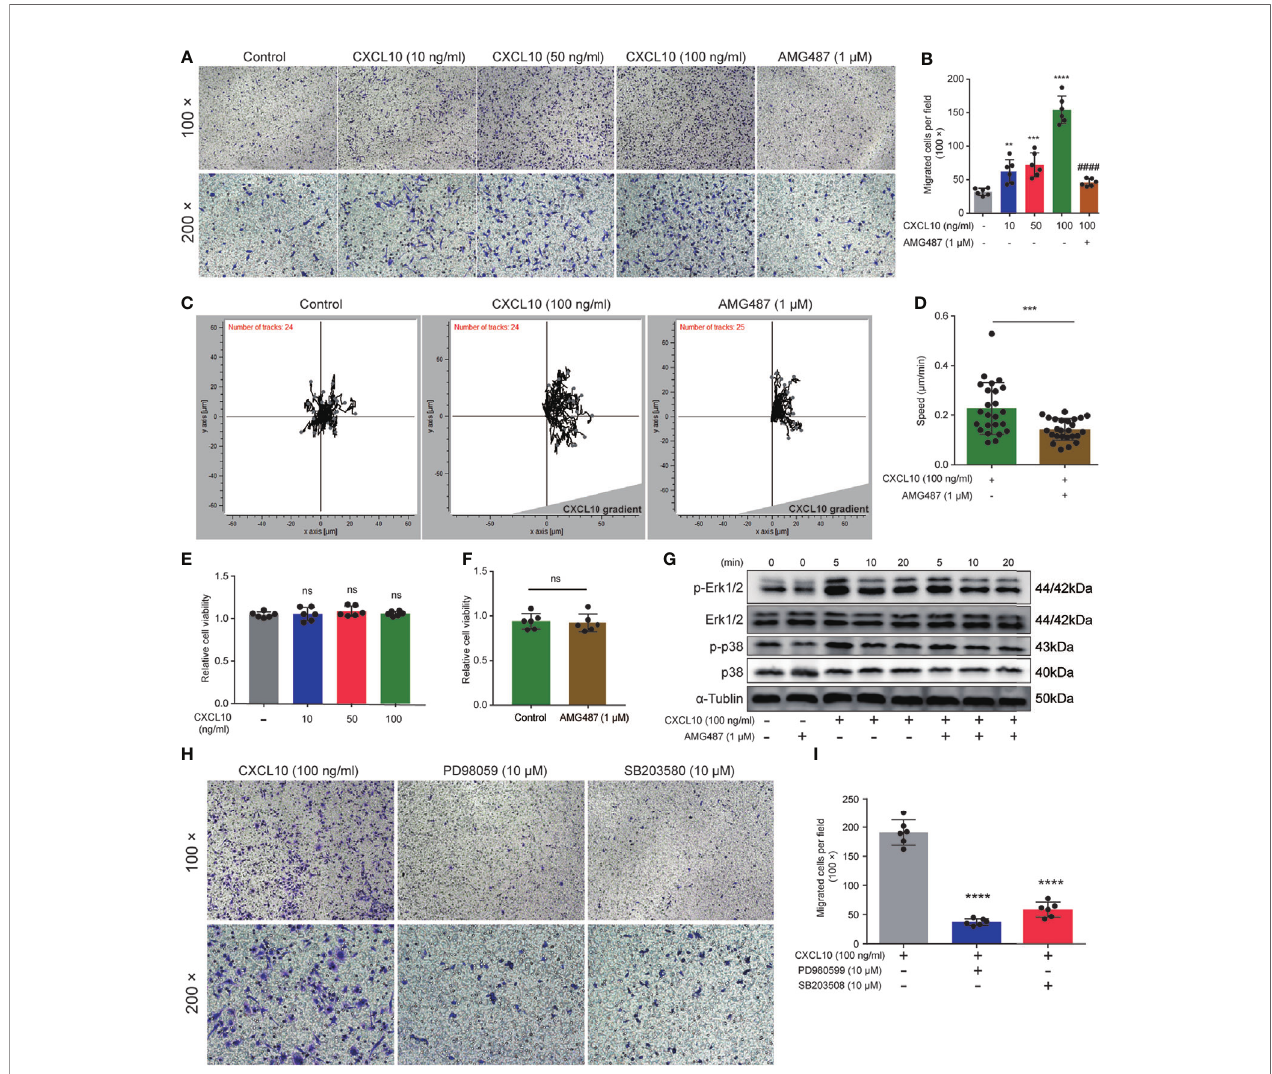
FIGURE 6 | CXCL10 promotes the migration of macrophages via CXCR3-mediated Erk and p38 MAPK activation. (A) Representative photographs of migration assay for bone marrow-derived macrophages (BMDMs) stimulated with rmCXCL10 (100 ng/ml) for 24 h after pretreating with AMG487 (1 m M) for 1 h. (B) The results of migration assay for BMDMs stimulated with rmCXCL10. (C) BMDMs were plated on m -Slide and analyzed for 10 h in the presence of CXCL10 gradient (100 ng/ml). (D) Cell speeds were compared for BMDMs between untreated cells and cells pretreated with AMG487 (1 m M) for 1 h. (E, F) The viabilities of cells treated with CXCL10 or AMG487 were evaluated with CCK-8 assays. (G) Cells were pretreated with AMG487 (1 m M) for 1 h, then with rmCXCL10 (100 ng/ml) for the indicated time, and the phosphorylated p38 MAPK and Erk1/2 levels in BMDMs were detected. (H, I) Representative photographs and the results of migration assay for BMDMs stimulated with CXCL10 (100 ng/ml) for 24 h after pretreating with Erk1/2 inhibitor or p38 MAPK inhibitor for 1 h. Data are shown as mean ± SD by one-way ANOVA analysis (B, E, I) and by unpaired, two-tailed Student ’ s t -test analysis (D, F) . “ #### ” indicates P < 0.0001 compared between the CXCL10 group and the CXCL10 and AMG487 groups. “ ns ” indicates P > 0.05; ** P < 0.01; *** P < 0.001; **** P <